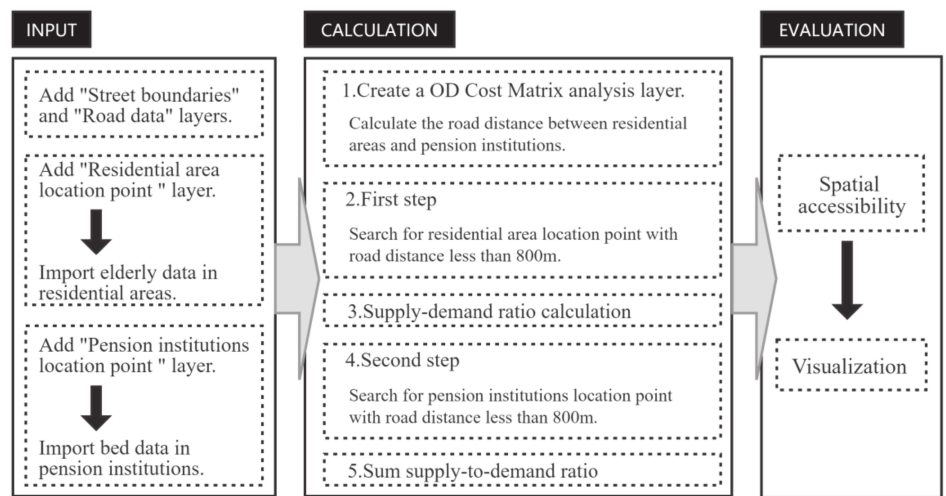
Figure 2. Implementation of the 2SFCA model in the geographic information system